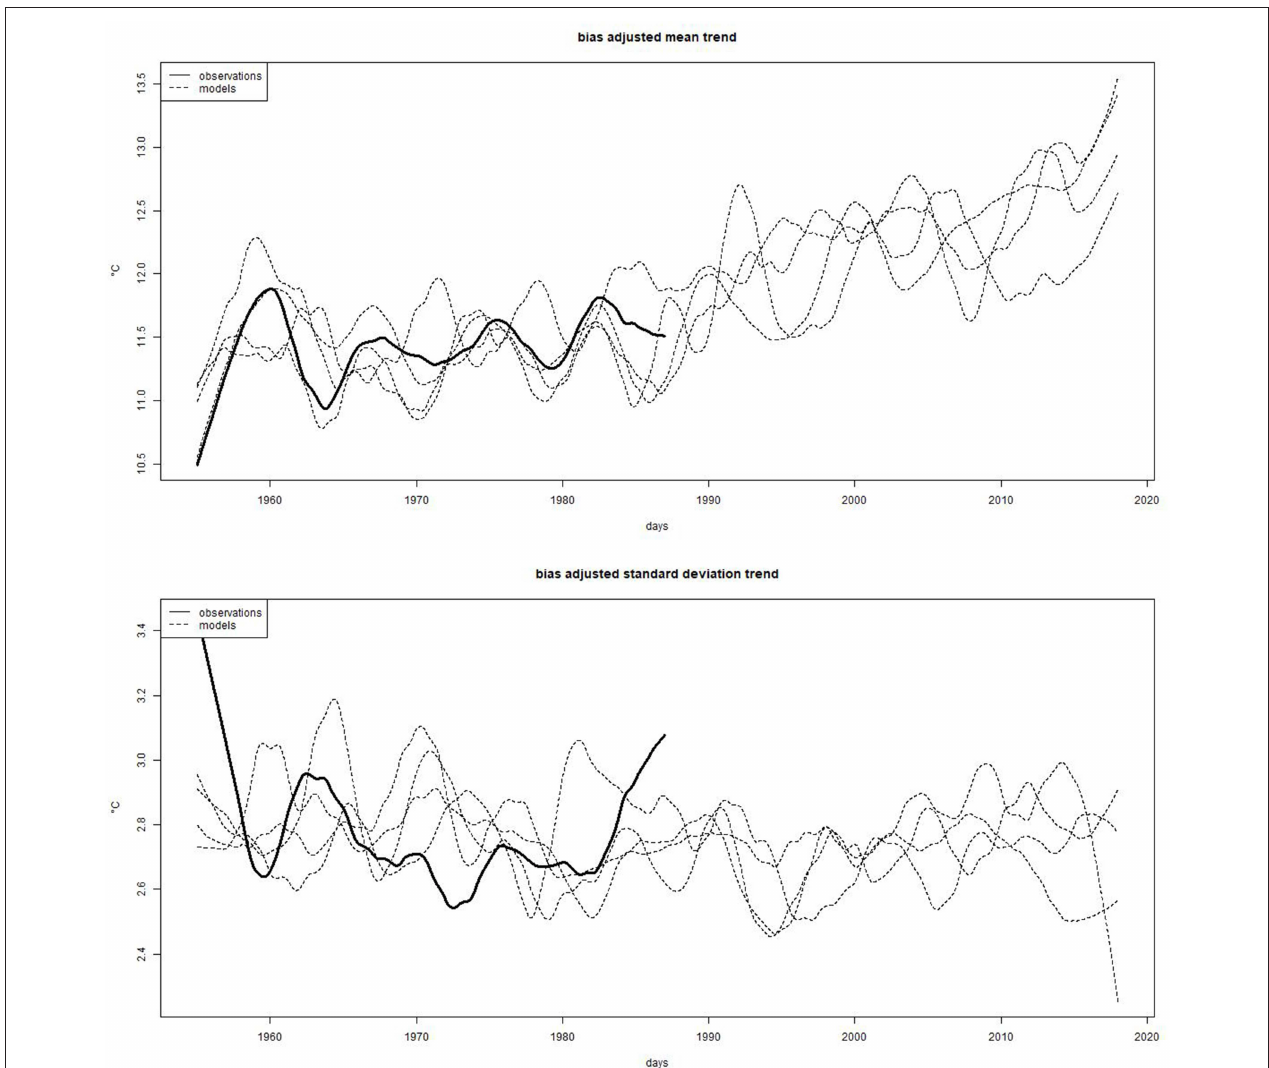
FIGURE 4 | Bias adjusted trends in mean (top panel) and standard deviation (bottom panel) extracted from four climate model simulations (dotted lines) with the observed trends in the calibration period 1955–1986 (black